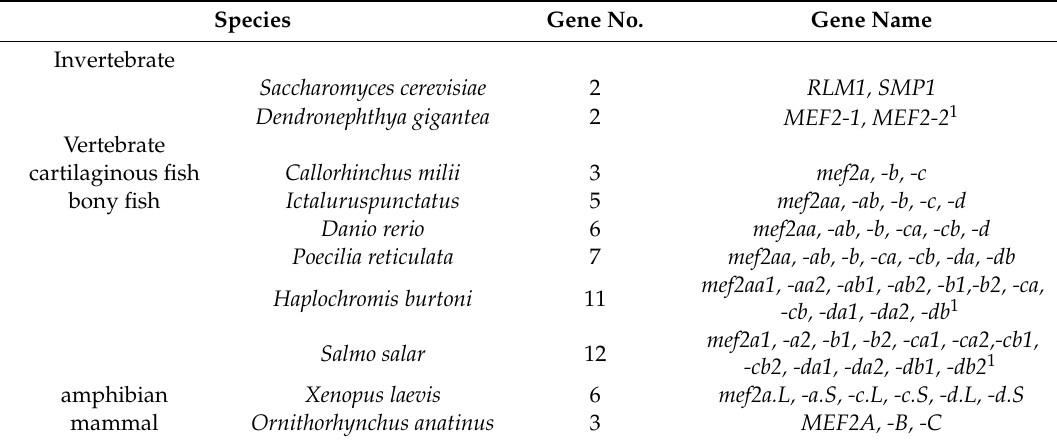
Table 1. Example species with an exceptional number of mef2